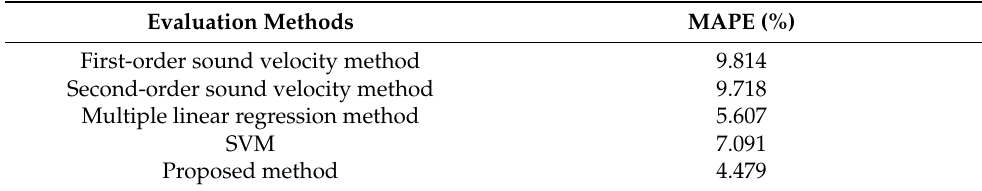
Table 5. MAPE values of different ultrasound evaluation models.